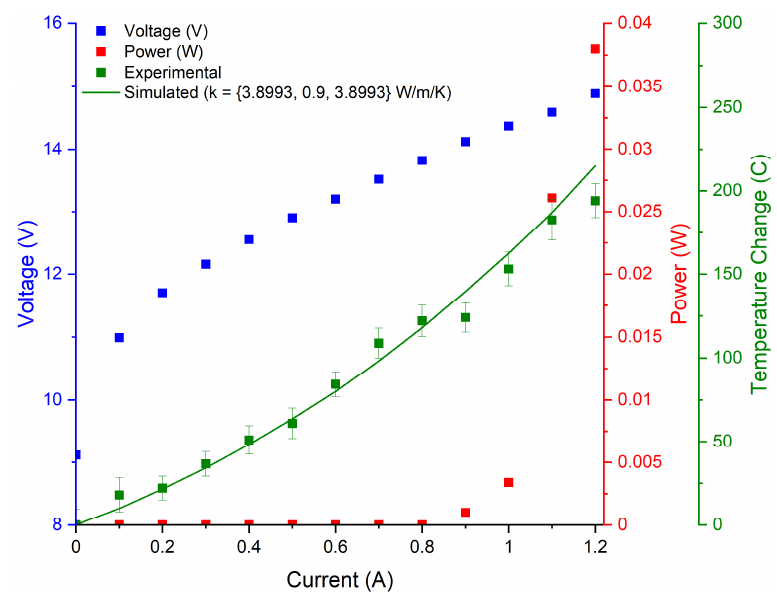
Figure 5. Temperature curves for D41 device also emitting at 3.7 μ m. Cross-plane thermal conductivity is reported as 0.9 W/(m·K), same as the S25 device. Device dimensions are 5 mm × 8 μ m.